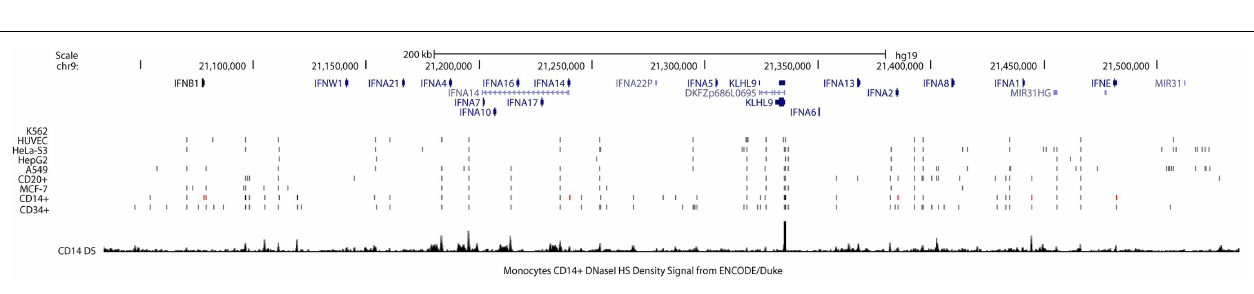
position marked by DNaseI hypersensitivity sites from ENCODE/OpenChromatin (Duke University) for each cell type. Red lines indicate the novel sites identified between cell types.The DNase I hypersensitivity signal peaks for CD14 + monocytes are shown at the bottom for reference to chromatin